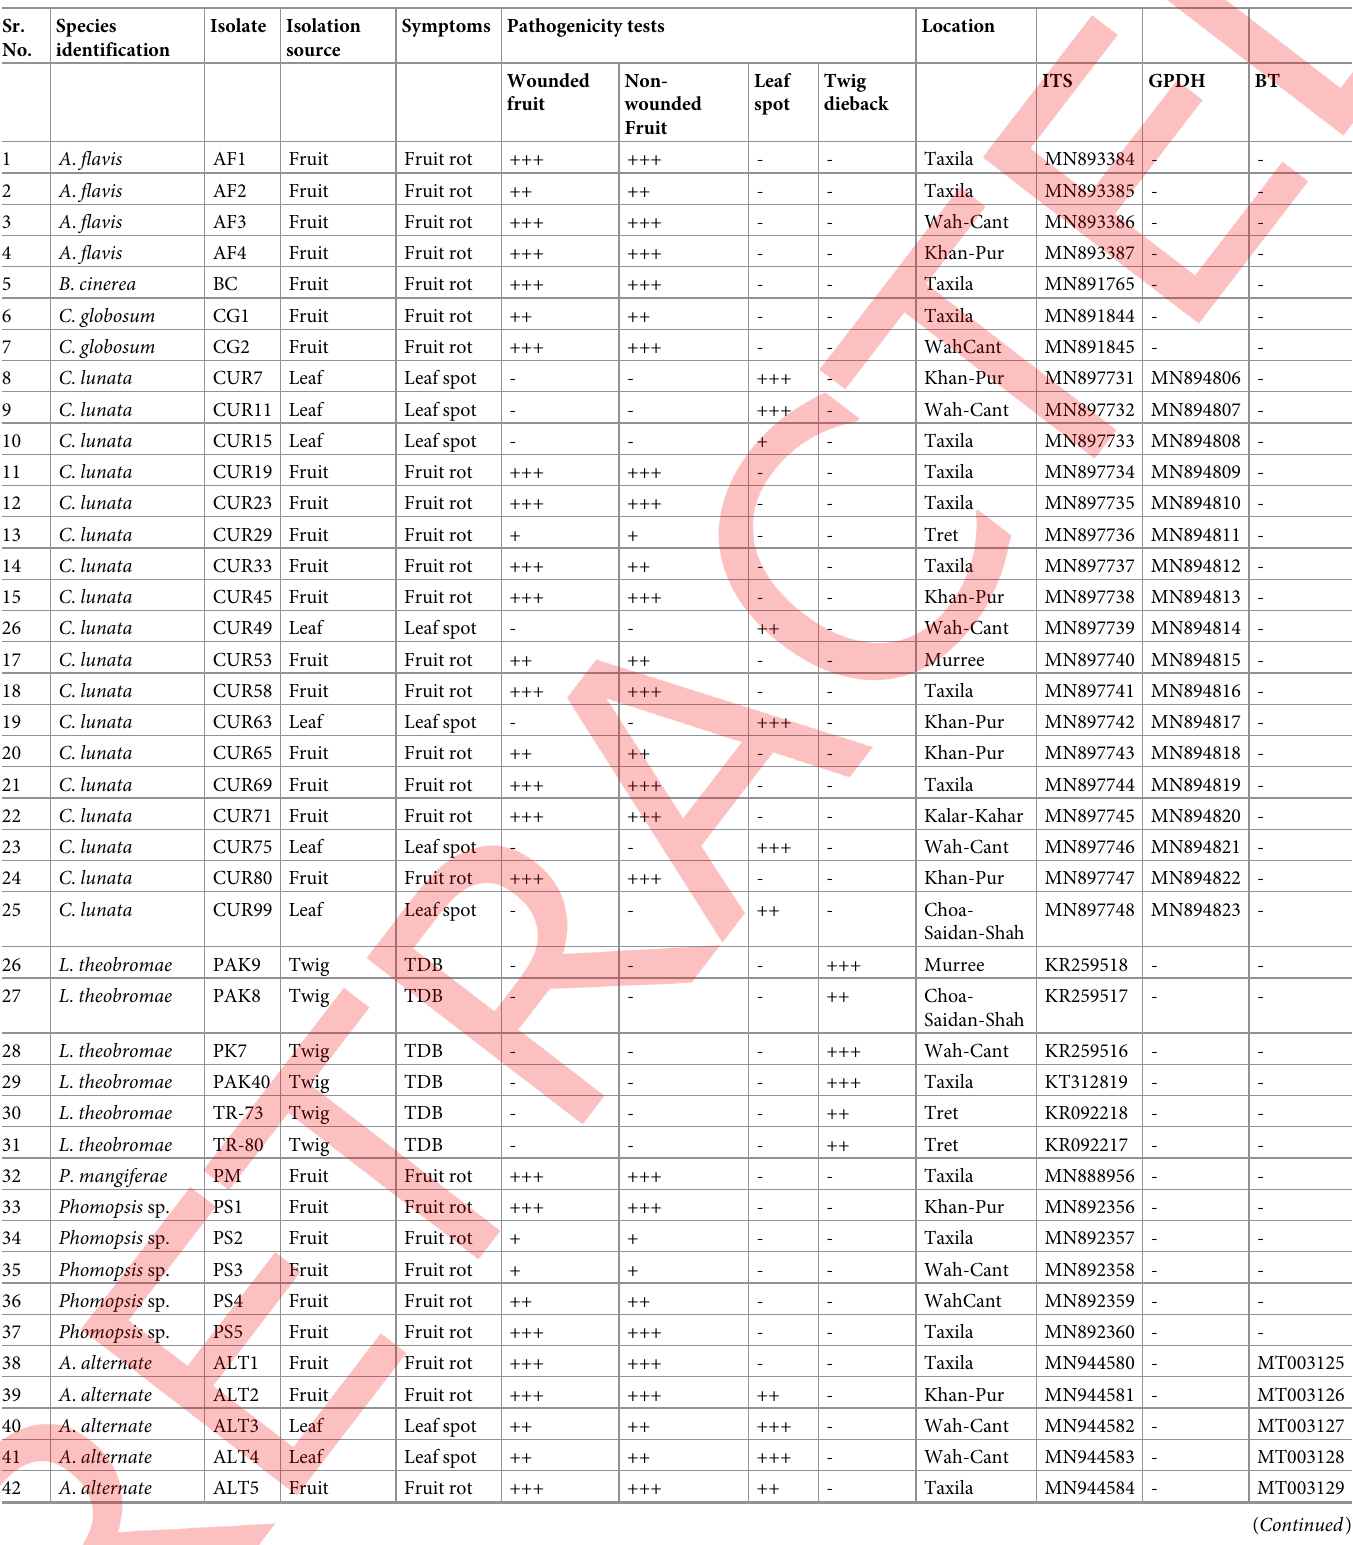
Table 3. Total number of fungal isolates isolated from major loquat growing areas of